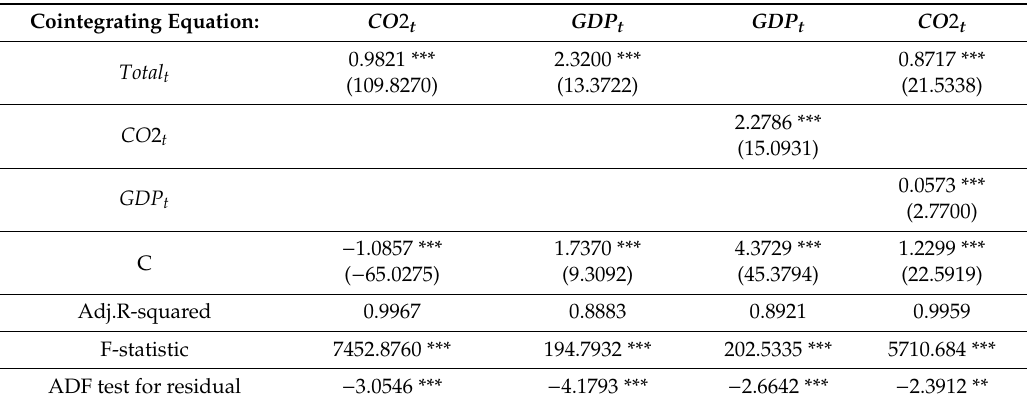
Table 5. Cointegration relationship for CO 2 t and GDP t